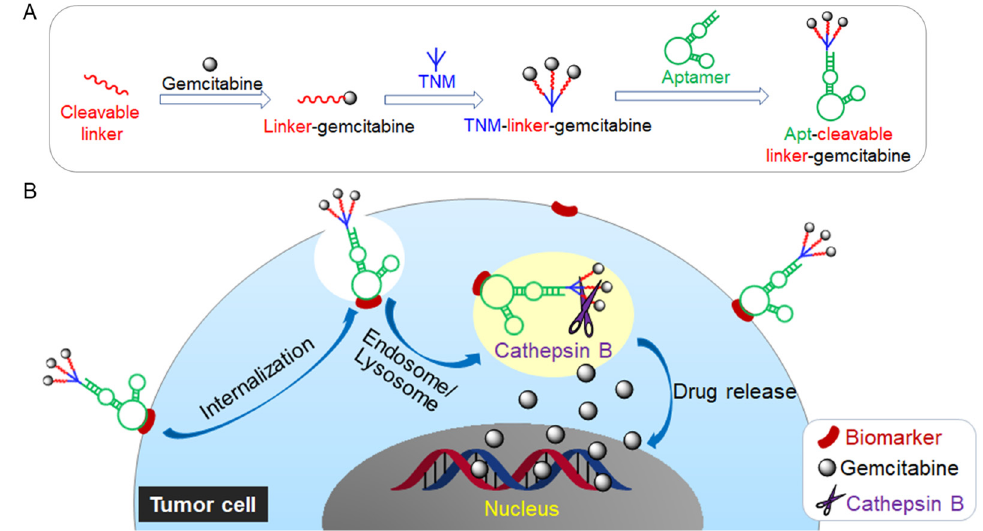
Figure 1. ( A ) Schematic illustration of the construction of Aptamer, enzymatically cleavable peptide Linker, and tri-Gemcitabine (Apt–cL–triGemcitabine) drug conjugate. ( B ) Targeted chemotherapy by Apt–cL–triGemcitabine with enzymatically controlled lysosomal drug release.